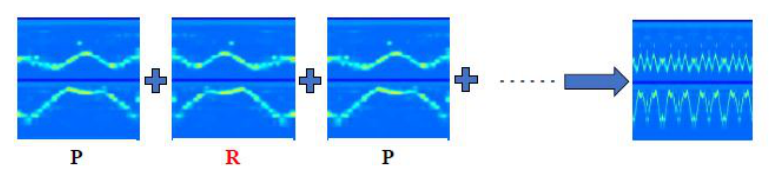
Figure 5. Illustration of creating a multi-cycle exercise video.